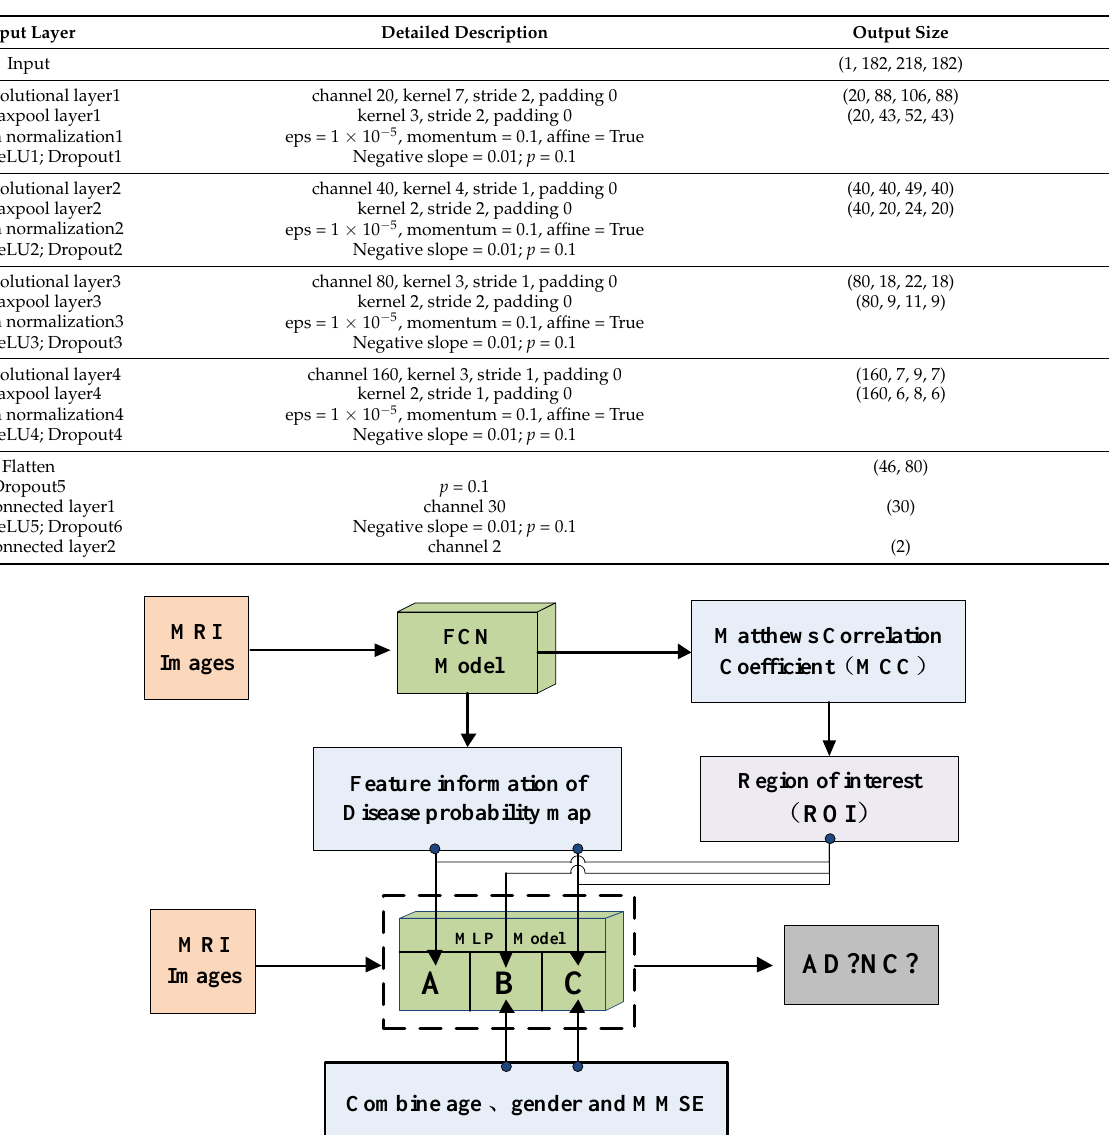
Table 2. The parameter settings of CNN model.